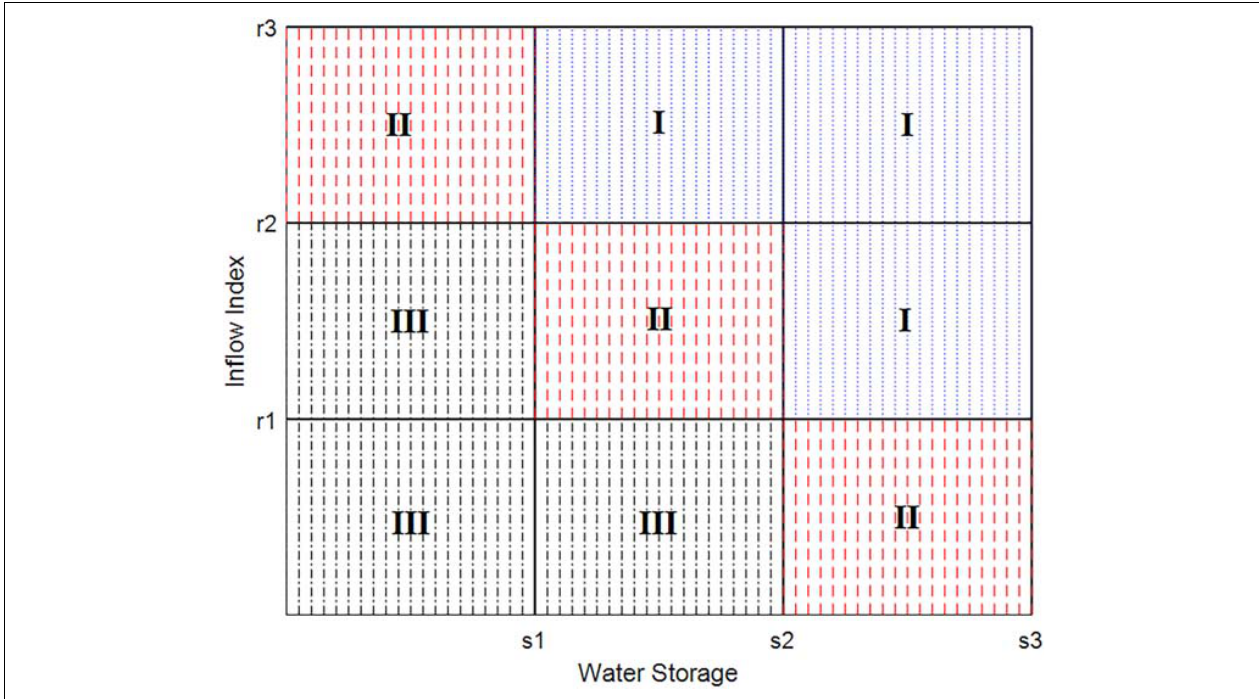
FIGURE 3 | The two-dimensional water diversion scheduling diagram.